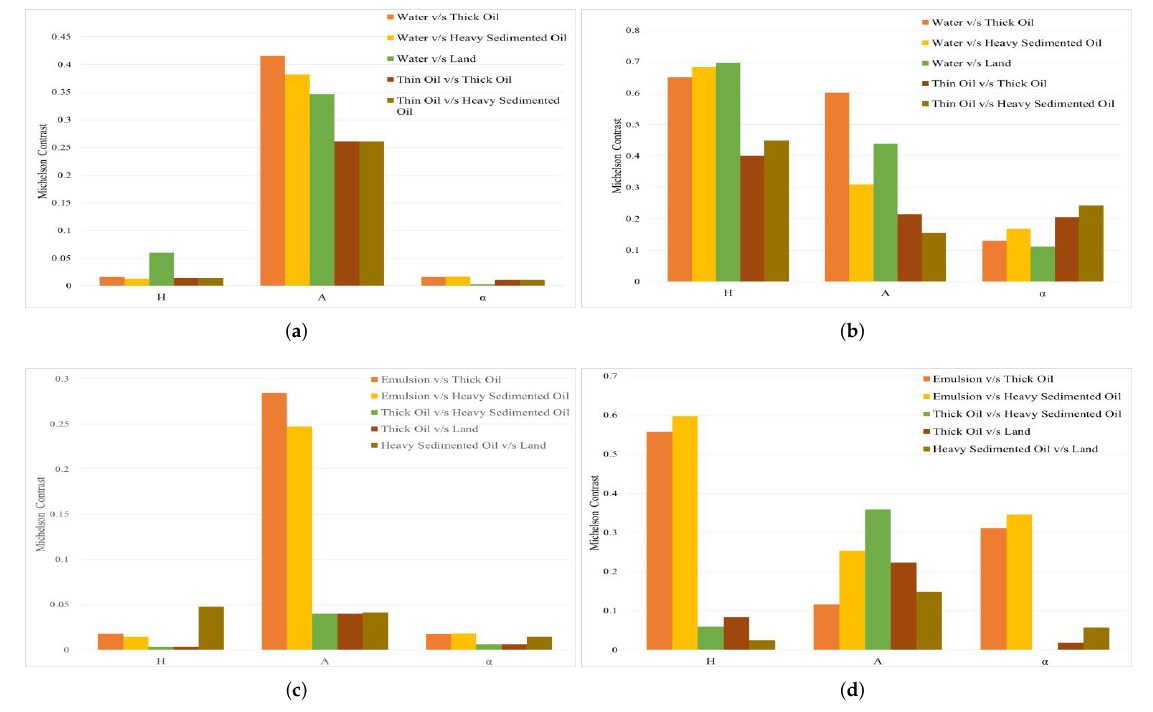
Figure 12. Michelson Contrast result analysis with respect to different types of polarimetric feature. For Conventional T3 ( a ) Different types of oil slick versus seawater& ( c ) Comparison of Different type Weathered Oil slick & look-alikes. For Proposed Log Transformed T3 ( b ) Different types of oil slick versus seawater& ( d ) Comparison of Different type Weathered Oil slick & look-alikes.